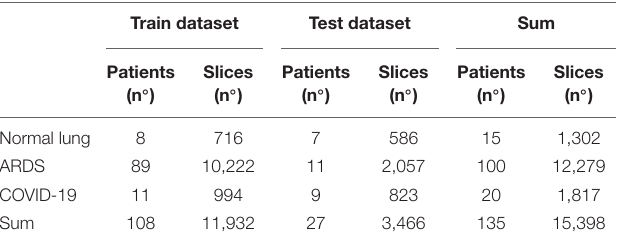
TABLE 1 | Summary of the datasets used to train and test the convolutional neural network.